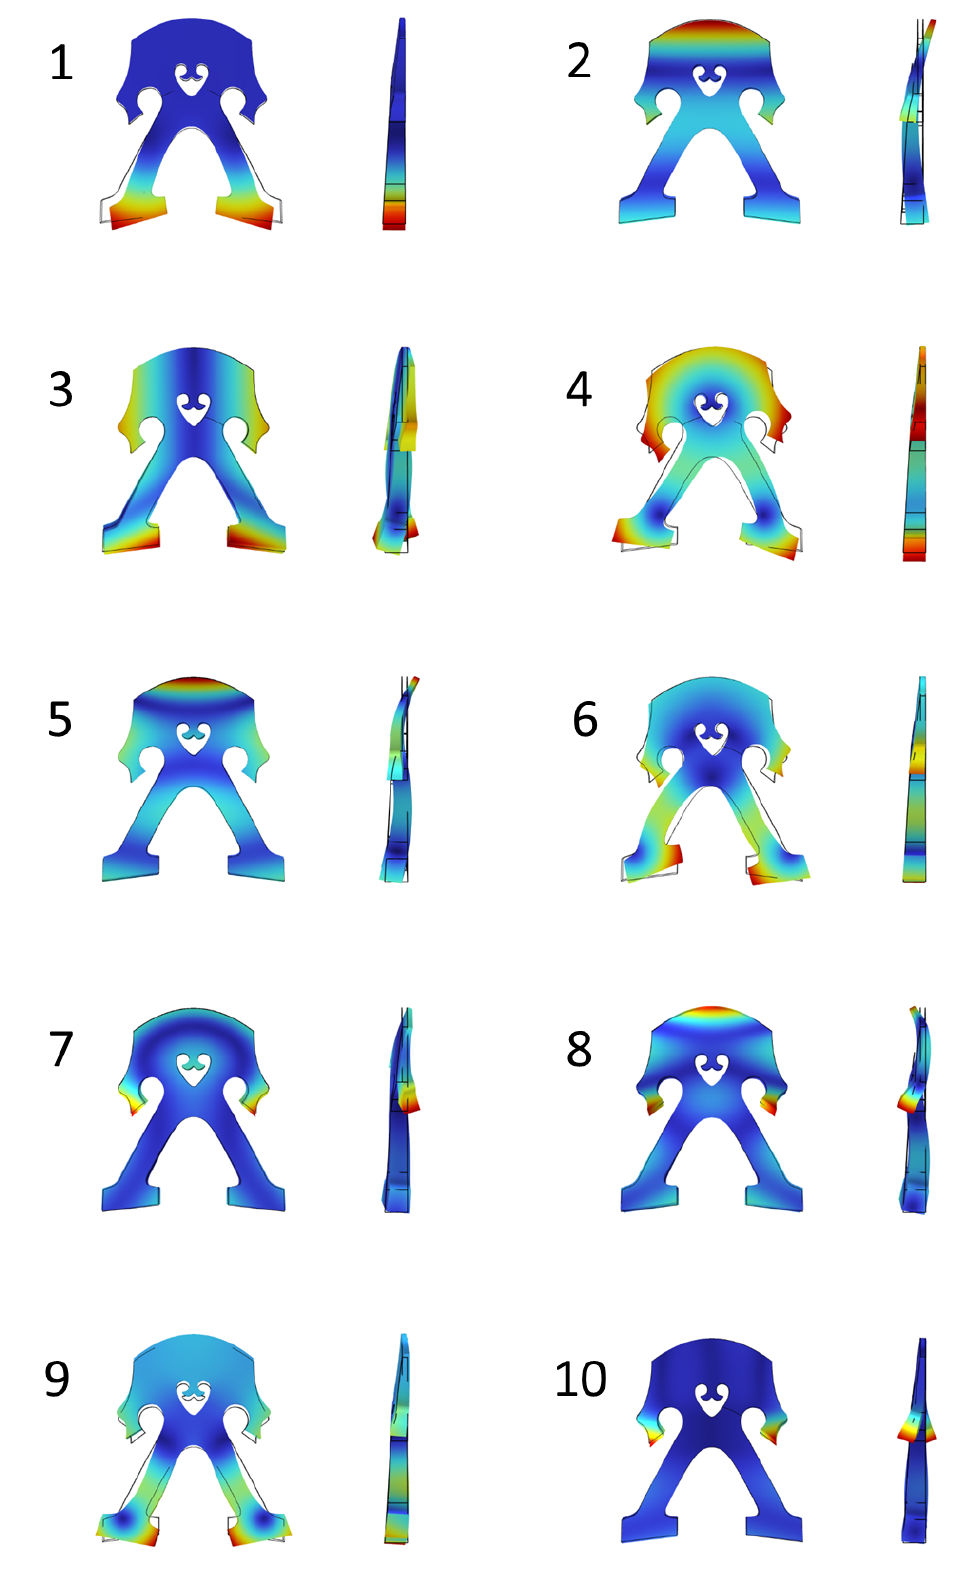
Figure A3. Mode shapes in free boundary conditions (case (a)) for Model